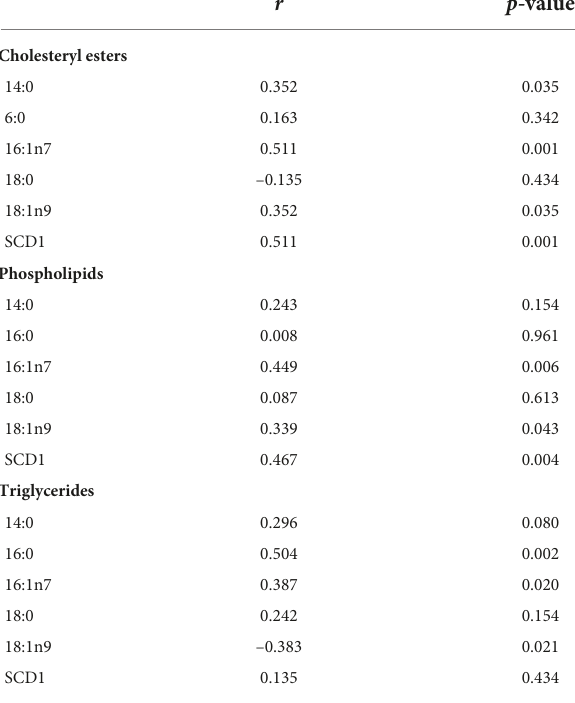
TABLE 4 Correlations between the change of liver fat content and the change of plasma fatty acid composition in all participants.